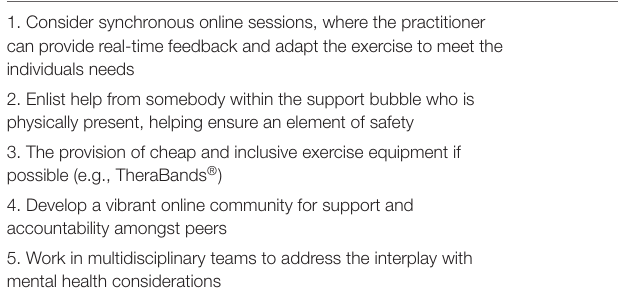
TABLE 4 | Recommendations for promoting physical activity in individuals with a neurologically-related mobility disability during the COVID-19